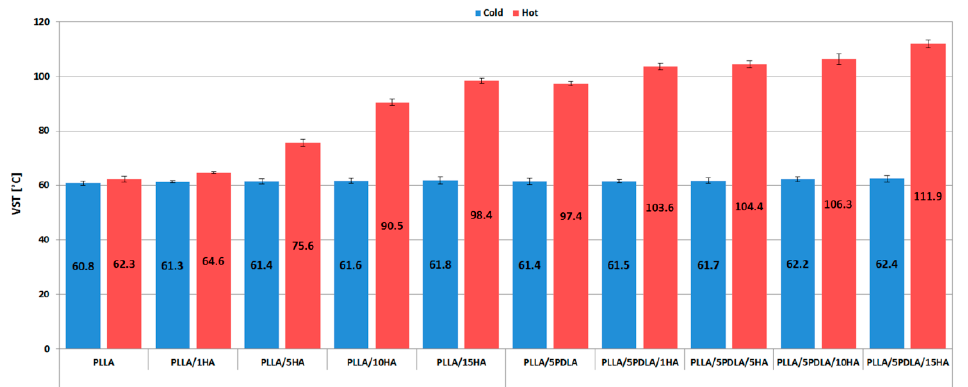
Figure 8. Vicat softening temperature plots of samples from cold and hot